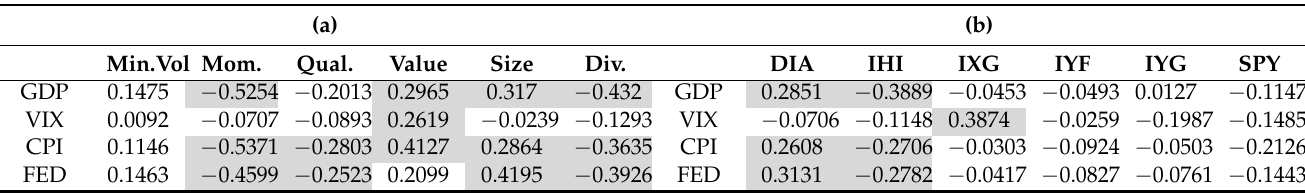
Table A8. Correlation between optimal weights of smart beta (a) and ETFs (b) and macroeconomic variables for α = 0.9. Significant correlations (5% significant level) are highlighted by gray